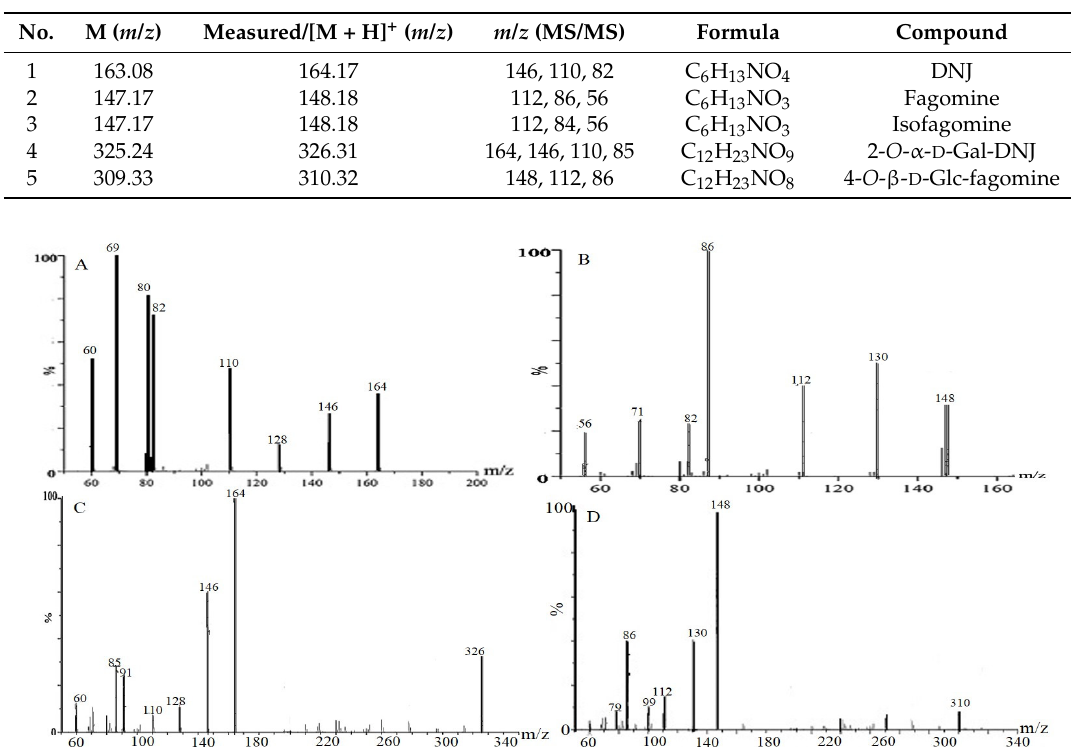
Figure 2. The secondary mass spectrograms of four M. alba alkaloid compounds: ( A ) DNJ; ( B ) Fagomine; ( C ) 2- O - α - D -Gal-DNJ; ( D ) 4- O - β - D -Glc-fagomine.